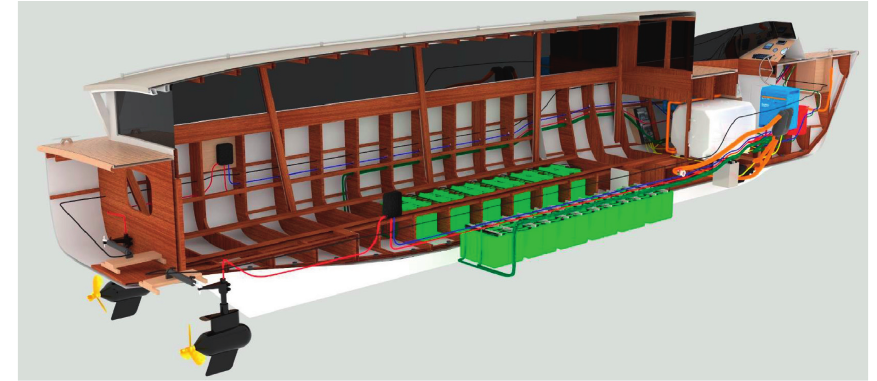
Figure 6: Rendering of the IPS system.